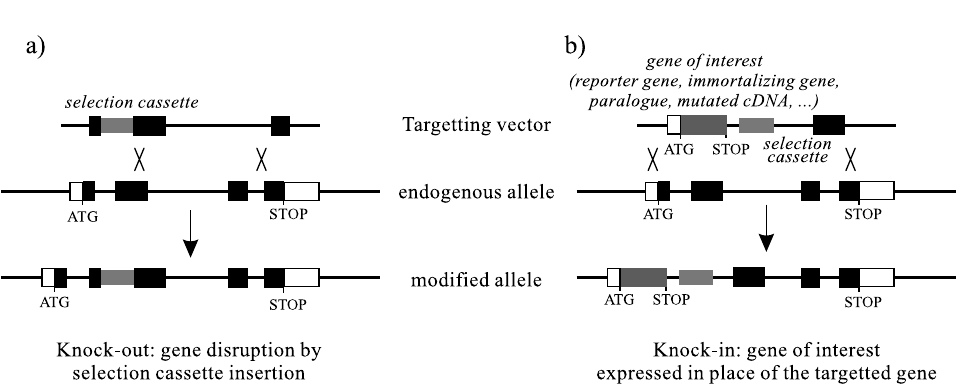
Fig. 2–Generalprincipleofhomologousrecombination. a)‘‘Knock-out’’.Thetargetingvectorincludesaselectioncassetteinsertedin an exon (black rectangle: coding region; white rectangles: non coding regions) and surrounded by regions of homology with the target gene. Recombination with the endogenous gene occurs within these homologous sequences and results in the creation of a null allele in which disruption of the gene is induced by insertion of the selection cassette. b) ‘‘Knock-in’’. In this variant, besides invalidation of the target gene, a gene of interest is introduced in the locus. Following homologous recombination, the gene of interest is placed under the control of the promoter and regulatory sequences of the target gene and is therefore expressed in place of the target